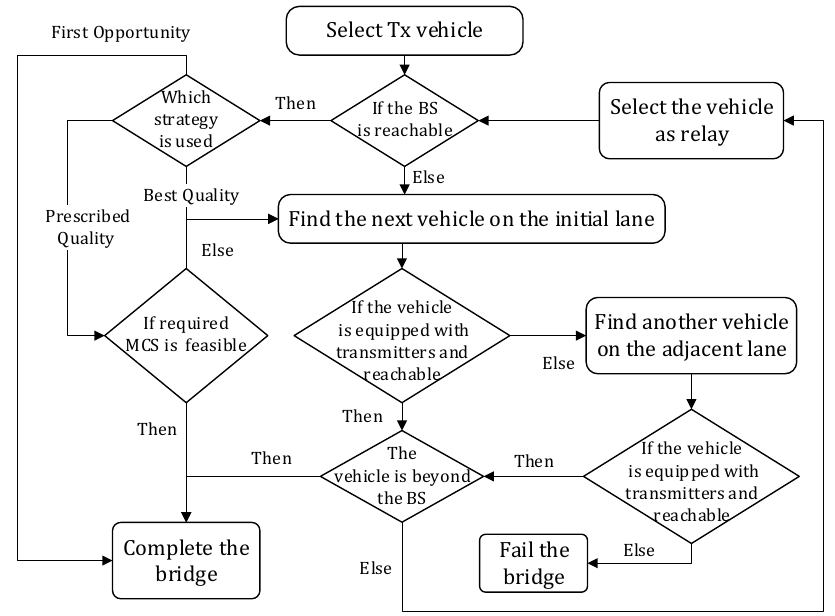
Figure 2. Algorithm for bridge